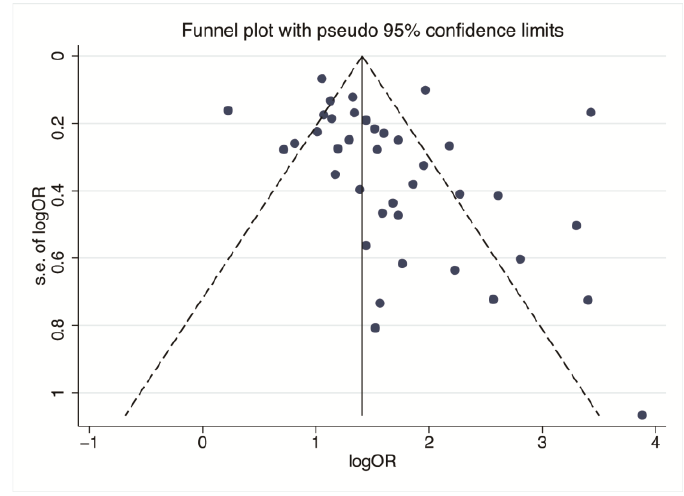
9 of 14 Figure 4. Sensitivity analysis of noise exposure and HFNIHL [14 – 52].